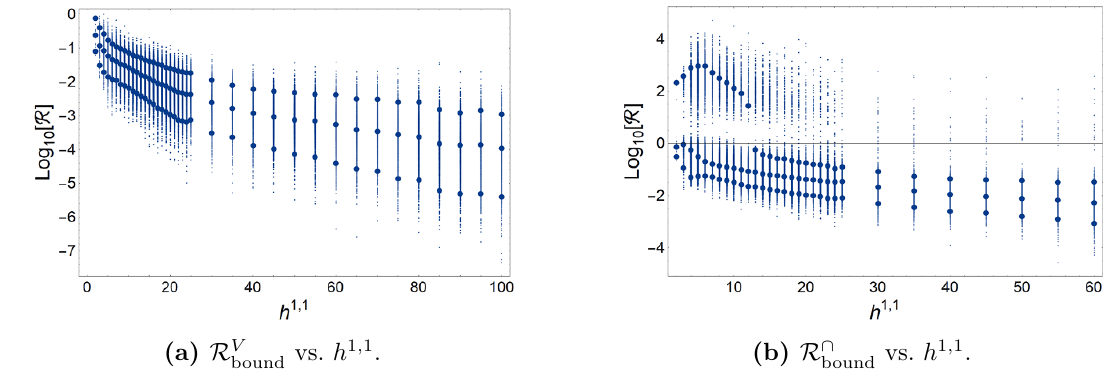
Figure 10. Upper bounds on the geometric (cid:12)eld range, cf. (6.5), vs. h 1 ; 1 . Left: log Right: log ( R \ ). 5th, 50th, and 95th percentiles are 10 bound